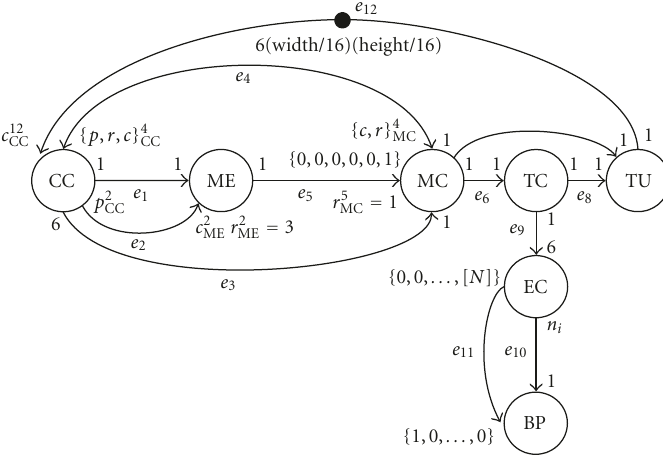
Figure 12: CSDF graph representing the partitioning of the MPEG-4 part 2 SP encoder scheme.